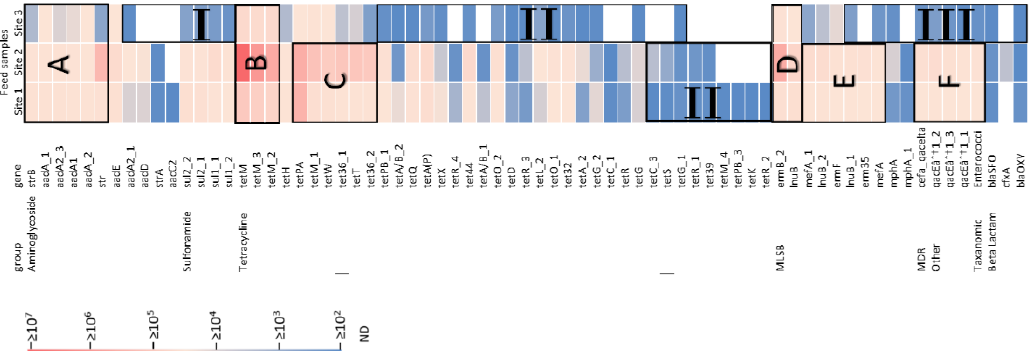
Figure 2. Absolute ARG concentration (per 100 µL) profile, resistance to different antibiotic groups in each sampling site. Zones (A), (B), and (D) are enriched in all sampling sites; (C), (E), and (F) are enriched in sites 1 and 2 but not in site 3; Zones I, II, and III denoted the absolute ARG copy numbers ≤ 10³ per 100 µL.